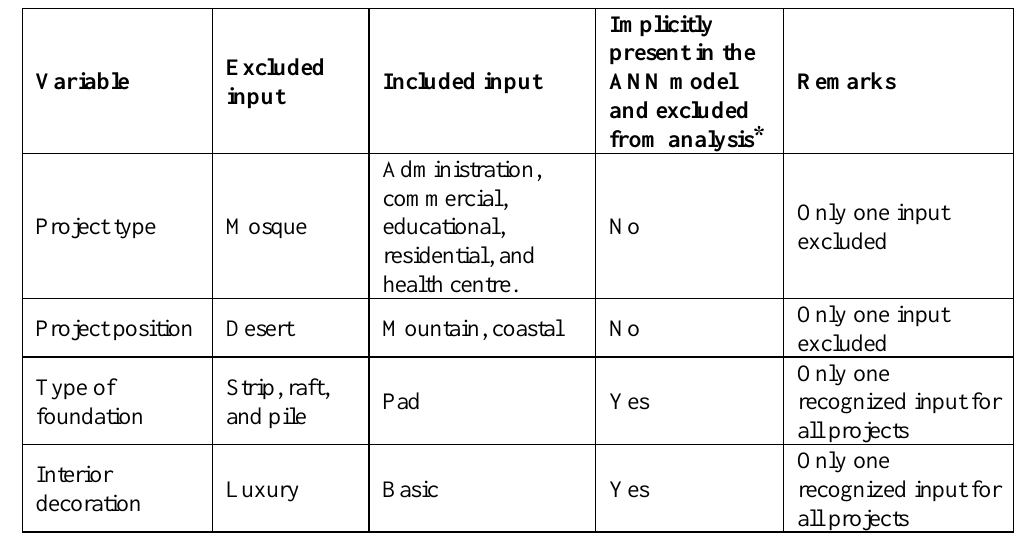
Table 2. Constraints of the variables (developed by the